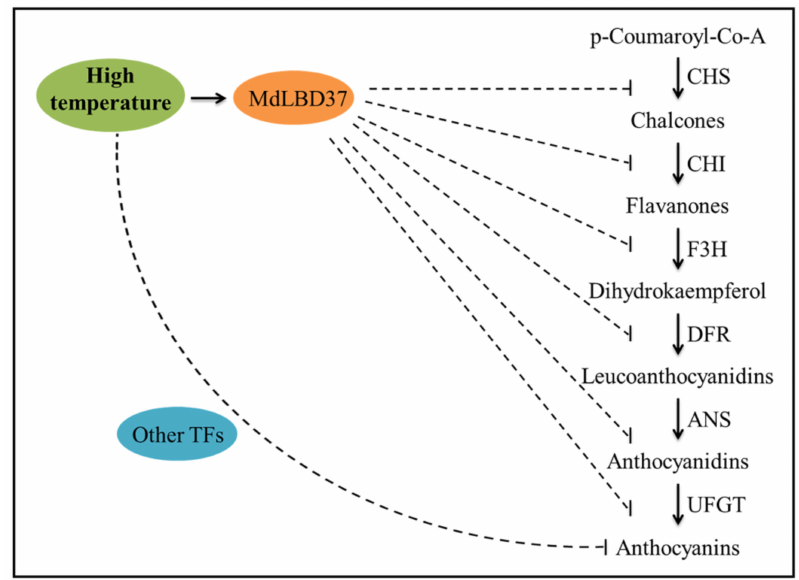
Figure 7. A hypothetical model depicting MdLBD37 and other TFs from the WGCNA module ‘green’ might be involved into the inhibition of high temperature on anthocyanin synthesis. The dotted line indicated possible